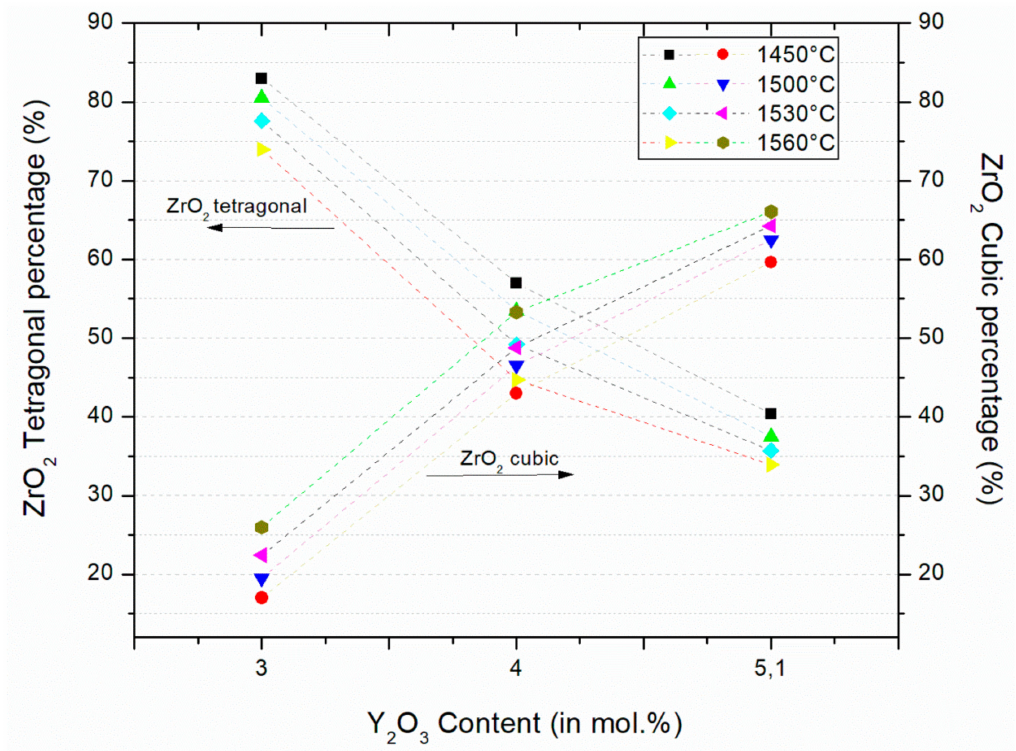
Figure 2. Zirconia tetragonal (T) and cubic (C) phase after sintering at 1450 ◦ C, 1500 ◦ C, 1530 ◦ C, and 1560 ◦ C. Calculation based on [10–12].